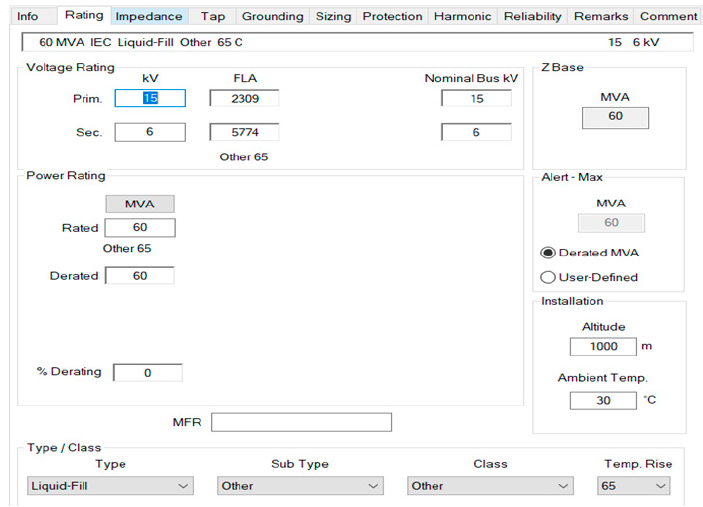
Figure 7. The nominal data for T5.